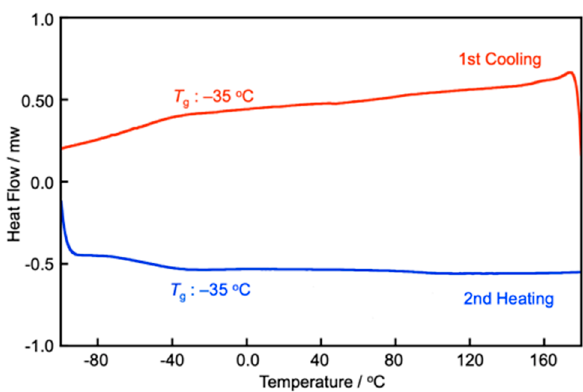
Figure 2. Differential scanning calorimetry (DSC) traces (right) of 1 12 at the rate of 10 K/min. Figure 2. Di ff erential scanning calorimetry (DSC) traces (right) of 1 12 at the rate of 10 K / min. Crystals 2020 , 10 x FOR PEER REVIEW